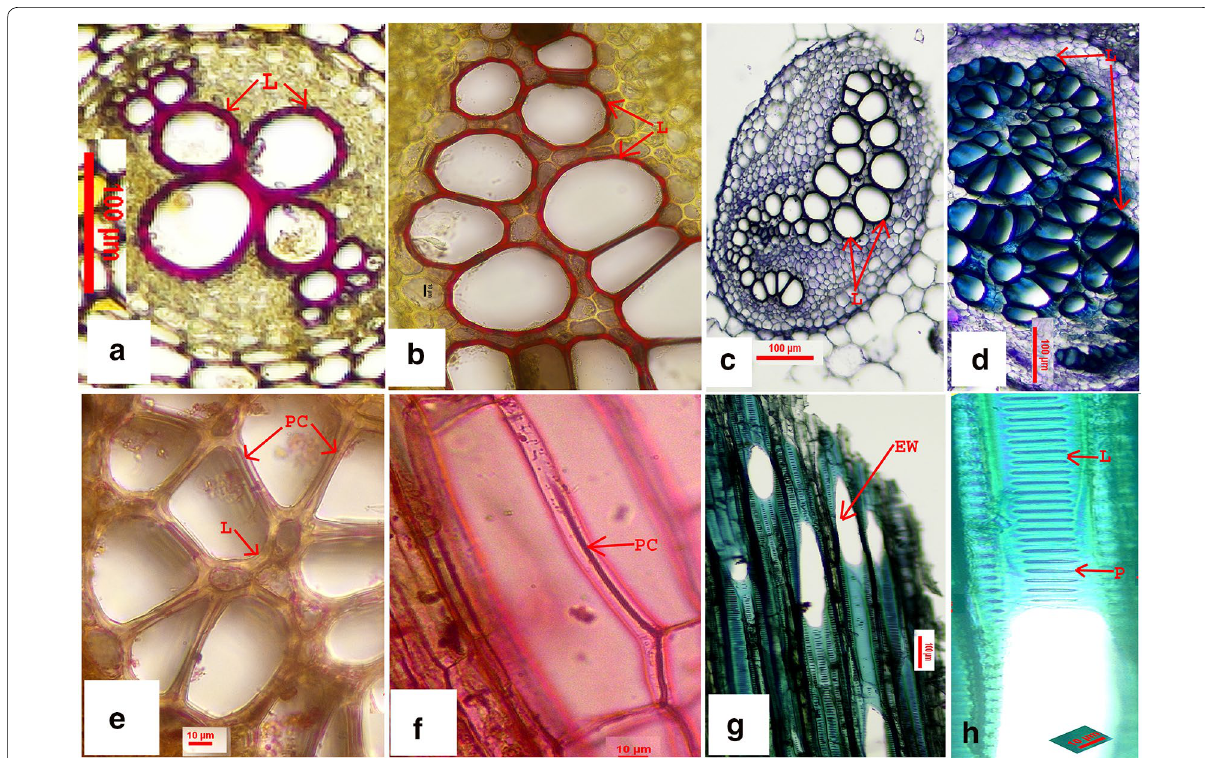
Fig. 2 Tracheary elements of Ampelopteris prolifera showing histochemical differentiation in tissue specific stain. a Vessel elements in root t.s. b – d Petiole t.s.(basal segment). b Lignified tissue stained with phloroglucinol-HCl. c , d Lignified tissue stained with toluidine blue o. e , f Pecto cellulosic middle lamella stained with ruthenium red. g , h Negatively stained endwall and stained lignified bars in the lateral wall in the l.s. of petiole showing vessel elements. (Abbreviations used: L lignin, PC pectocellulosic middle lamella, EW endwall, P